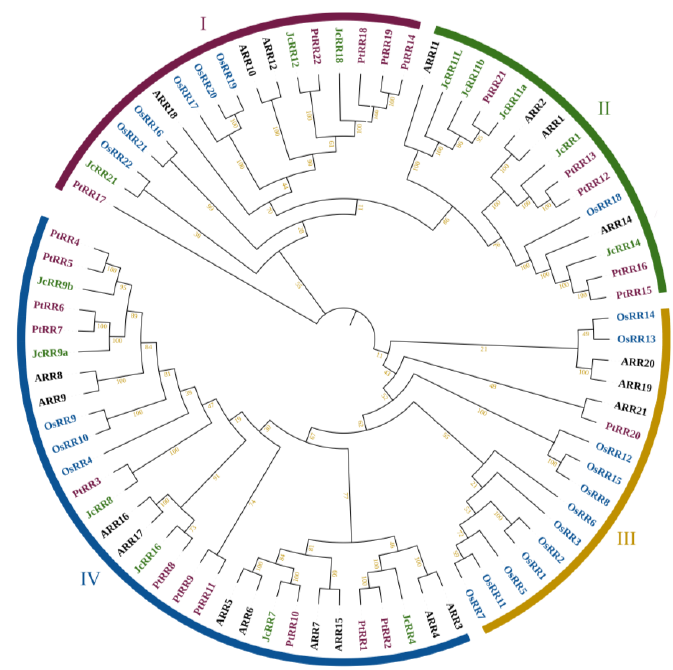
Figure 2. Phylogenetic tree of RR proteins among J. curcas ( Jc ), Arabidopsis, Populus, and rice. The unrooted phylogenetic tree was constructed via MEGA 7.0 by the neighbor-joining method with 1000 bootstrap replicates. The RRs were divided into four major subfamilies. The different subfamilies are indicated with different colors. The green, black, purple and blue words represent J. curcas , Arabidopsis , Populus and rice, respectively.